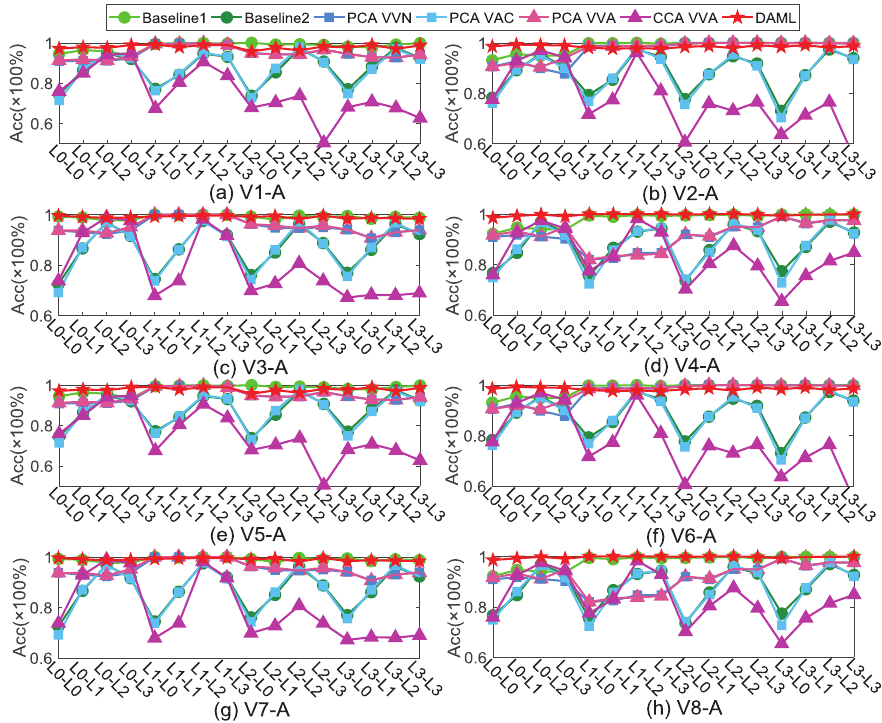
Figure 4. Diagnostic results under the condition of a 30% training sample size, ( a ) V1-A, ( b )